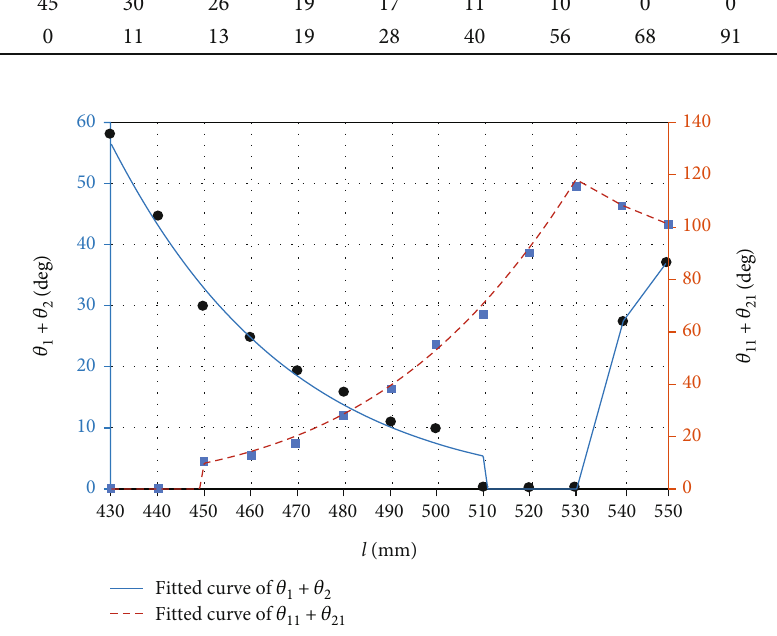
Figure 7: Fitting curves of di ff erent angles with various lengths of Bowden cable.